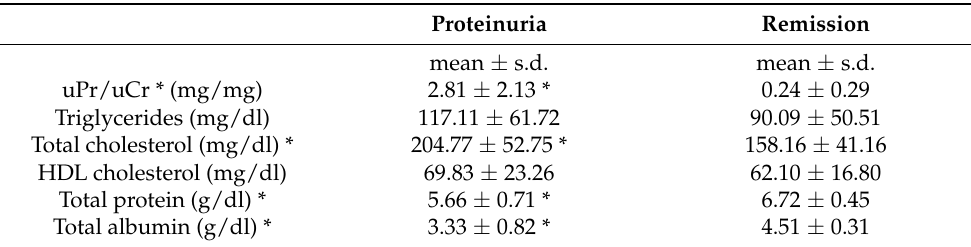
Table 1. Biochemical data during proteinuria and